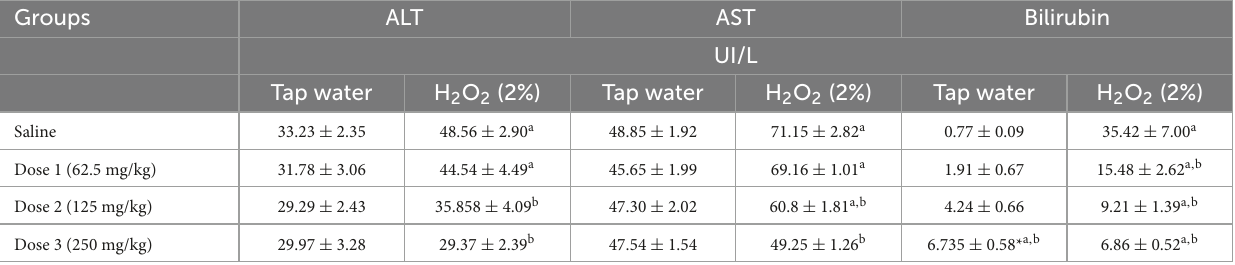
TABLE 3 Hepatic biomarkers